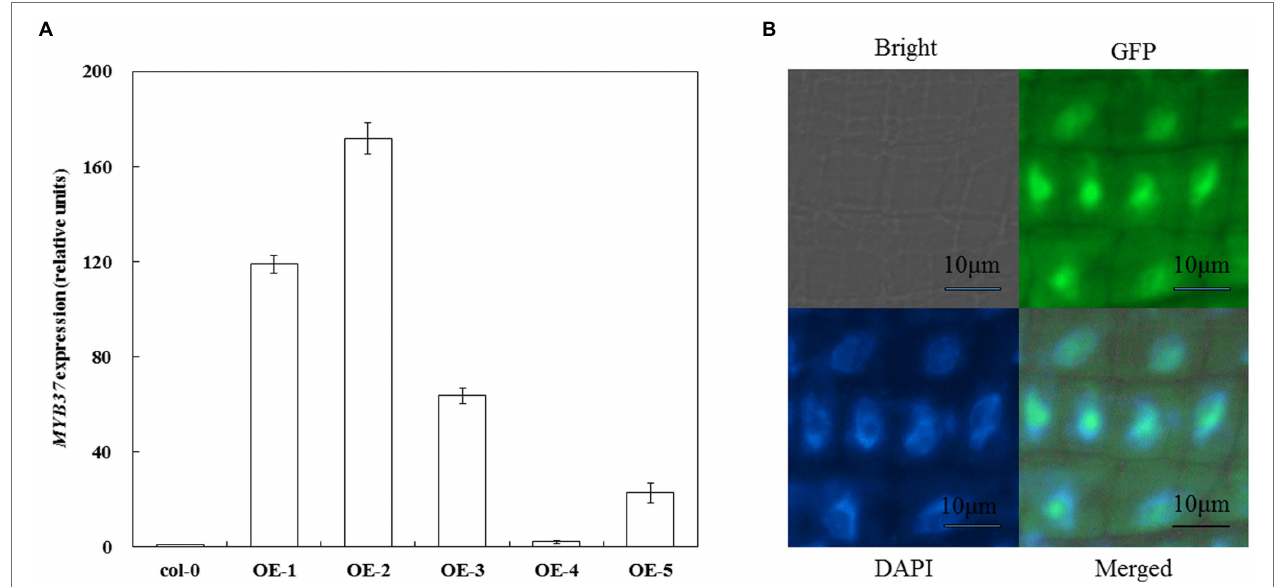
FIGURE 1 | Detection of MYB37 expression level in Col-0 and overexpressed plants using qRT-PCR (A) and subcellular localization of MYB37 (B)